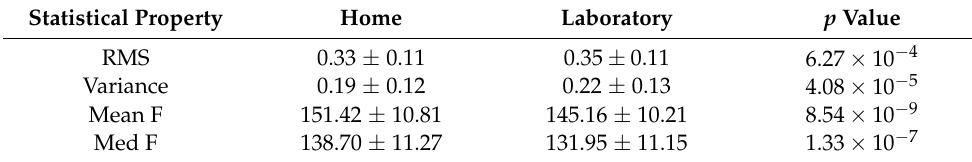
Figure 2. The average statistical properties of sEMG over the respective number of calibrations for each participant at home and in the lab: ( a ) root mean square values; ( b ) variances; ( c ) mean frequency; ( d ) median frequency. Table 2. The results of sign tests of calibrations for all participants in the laboratory and at home.